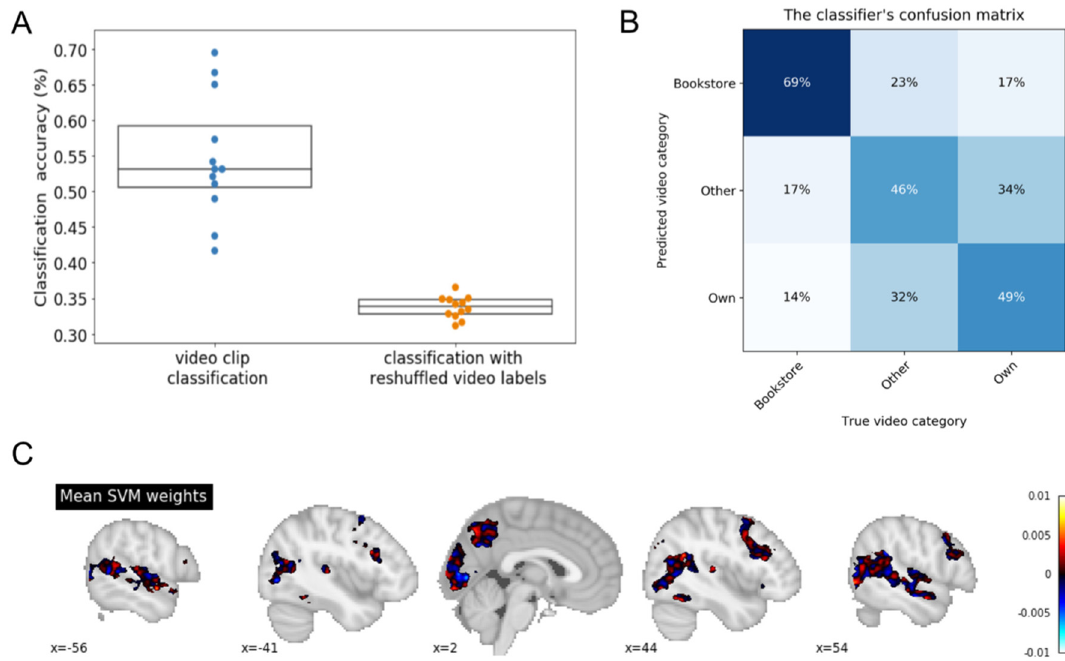
Figure 2. Leave-one-participant-out CV analysis. ( A ) Classification accuracies for the 12 participants (in blue). The model was trained on 11 participants and was tested on a single participant. This process was repeated 12 times such that each participant’s data served as test dataset once. As a control, the same procedure was repeated 10 times with randomly- reshuffled video labels (mean chance-classification accuracy for each participant in orange). ( B ) Confusion matrix for the three-way classifications. Percentages indicate the distribution of the classifier’s guesses for each video category. Shown here is the average confusion matrix across the 12 participants. ( C ) Average feature importance maps of the classifier (all data). Fronto-prietal regions, dorsolateral prefrontal cortex, precuneus, mid-temporal regions, visual cortex, and fusiform gyrus were particularly diagnostic in differentiating autobiographical experiences and non-personal experiences.